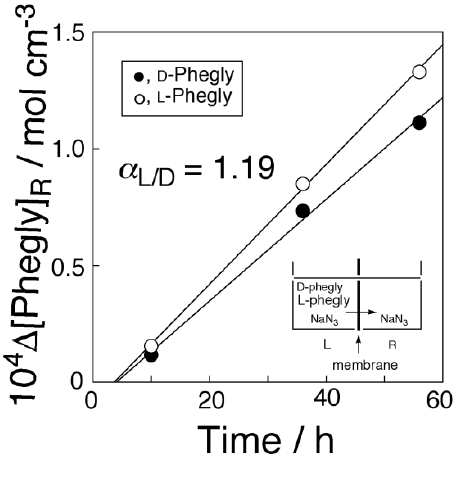
Figure 10. Chiral separation of reacmic mixture of Phegly through the PC18AAm liquid membrane (Operating temperature, 50 °C (323 K); [AAMC] = 4.13 × 10 − 5 mol·cm − 3 : = [ L -Phegly] = 1.0 × 10 − 6 mol·cm − 3 [ D -Phegly] L,0 L,0